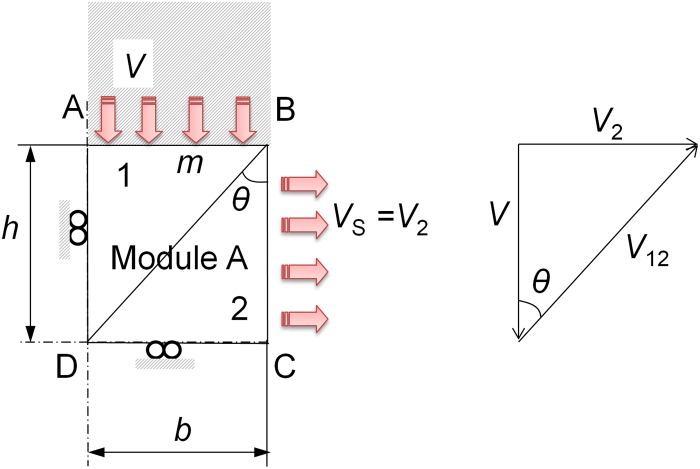
Module A analysis.